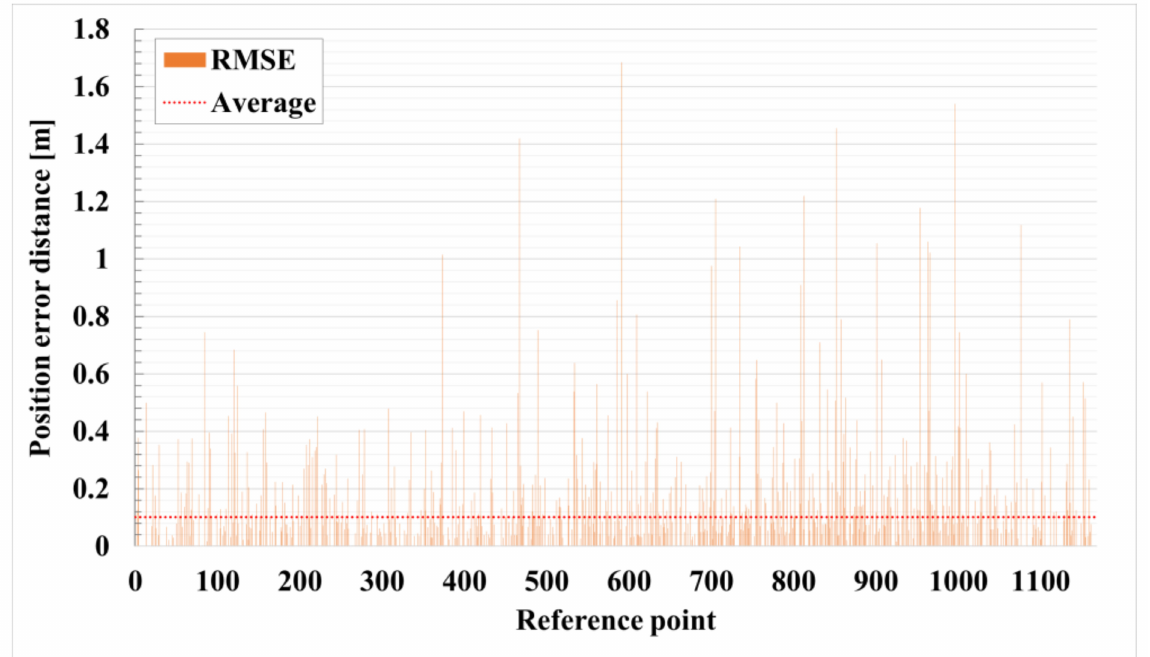
Figure 12. Positioning error distance for each reference point in the case of the proposed system. Figure 13 shows the relative distribution of the estimated location based on the actual location. In other words, this means how well the proposed network estimates the actual location of (0,0). The experimental results have an x-axis and a y-axis of the first